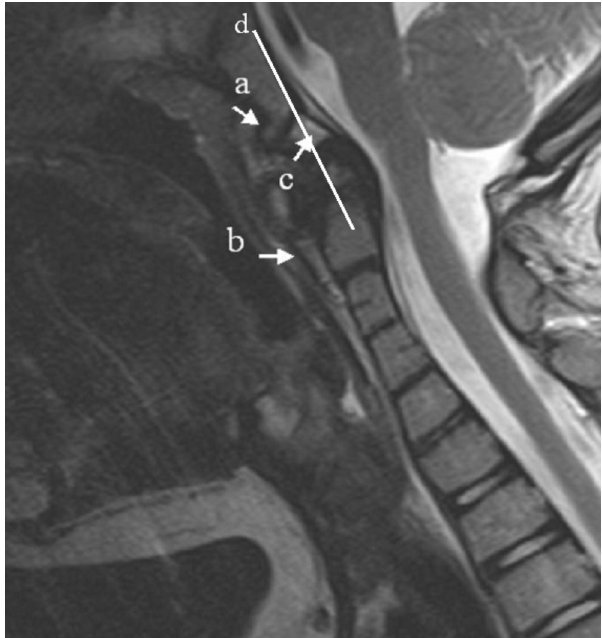
Figure 2 - Sagittal MRI imaging revealing discontinuity of the cervical liga- ments . Note the disruption of the anterior atlanto-occipital ligament, which connects the lower anterior clivus with the anterior aspect of the body of C2, as visualized by the superior continuation of the anterior longitudinal liga- ment. In addition, disruption of the anterior longitudinal ligament is evident (arrow-b). Note the dislocated atlas (arrow-c) and compression of the dura mater space. Line (d) represents the Wachenheim-clivus line (a method to evaluate craniocervical abnormalities). The line is drawn along the posterior aspect of the clivus, toward the odontoid process (OP). In normal subjects, the line is tangential to the posterior aspect of the OP. In contrast, in our patient, this line intersects the anterior aspect of the OP